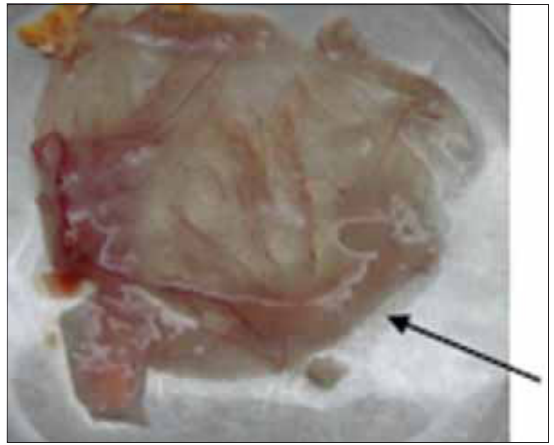
Figure-1: Oedematous thickening of chorioallantoic membrane produced by field at second passage